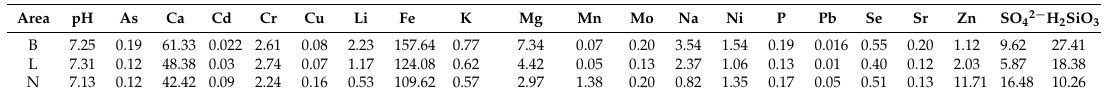
Table 4. Trace element and mineral levels in drinking water in longevity and non-longevity counties in